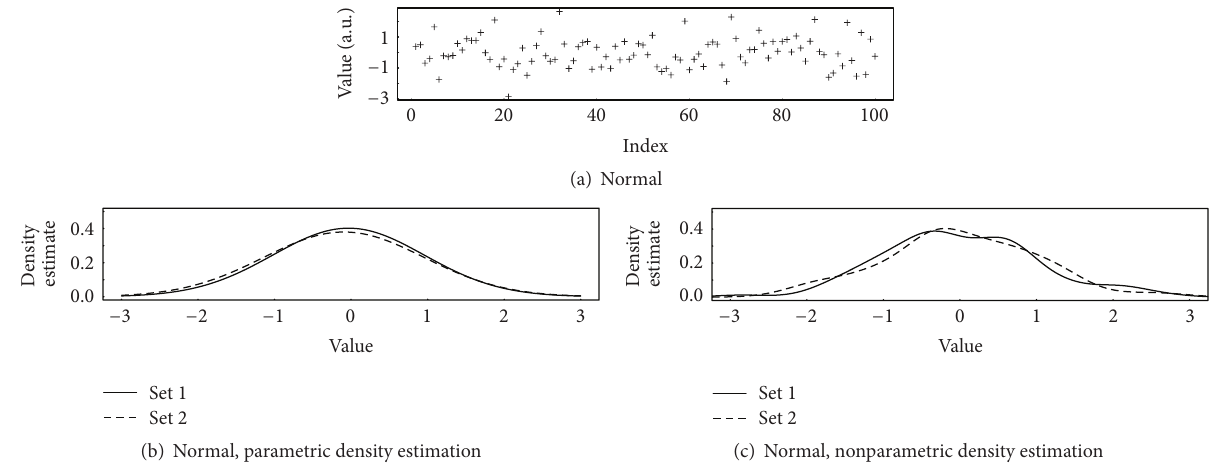
Figure 1: (a) 100 transformed observations 𝑦 𝑖 = (𝑥 𝑖 − 𝑥)/̂𝜎 , in arbitrary units (au), with 𝑥 𝑖 simulated as 𝑥 𝑖 ∼ iid 𝑁 ( 𝜇,𝜎 2 ); (b) the estimated probability density using parametric density estimation from two sets of 100 simulated and transformed observations as in (a); (c) same as (b) but using nonparametric density